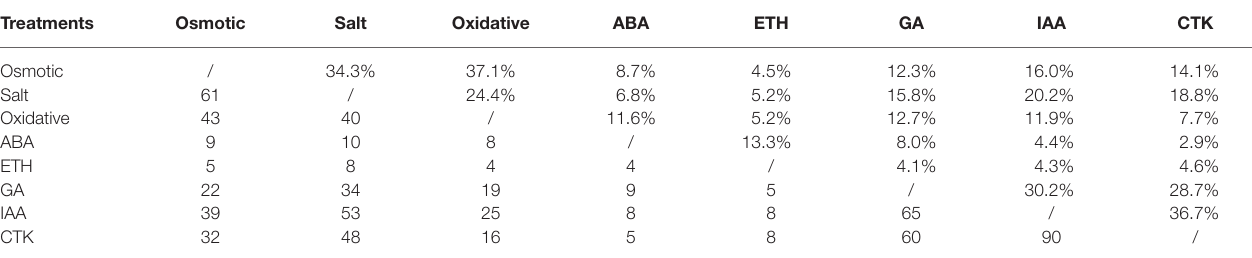
TABLE 1 | Number (below matrix) and proportions (above matrix) of PPR genes in responses to a pair of treatments. Treatments Osmotic Salt Oxidative ABA ETH GA Osmotic /